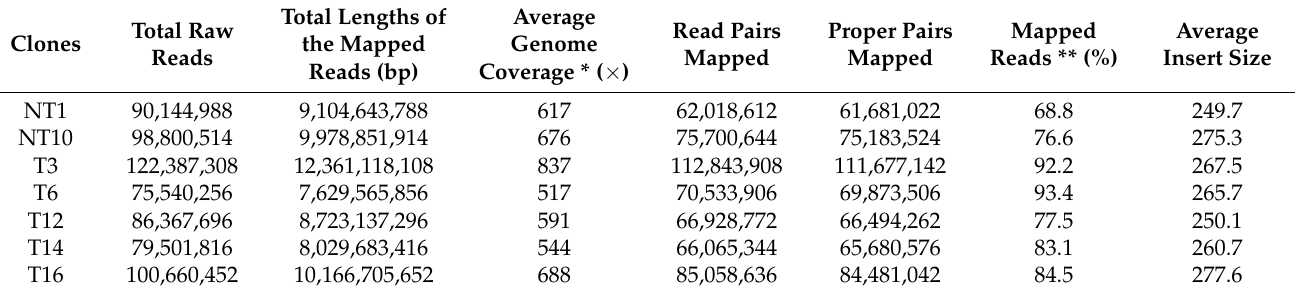
Table 1. Illumina sequencing and mapping statistics of reads from clonal lines against the O. tauri RCC1115 reference genome for untransformed (NTx) and transformed (Tx) clones. Total raw reads correspond to mapped and unmapped read pairs. The total length of the reference genome is 14,762,682